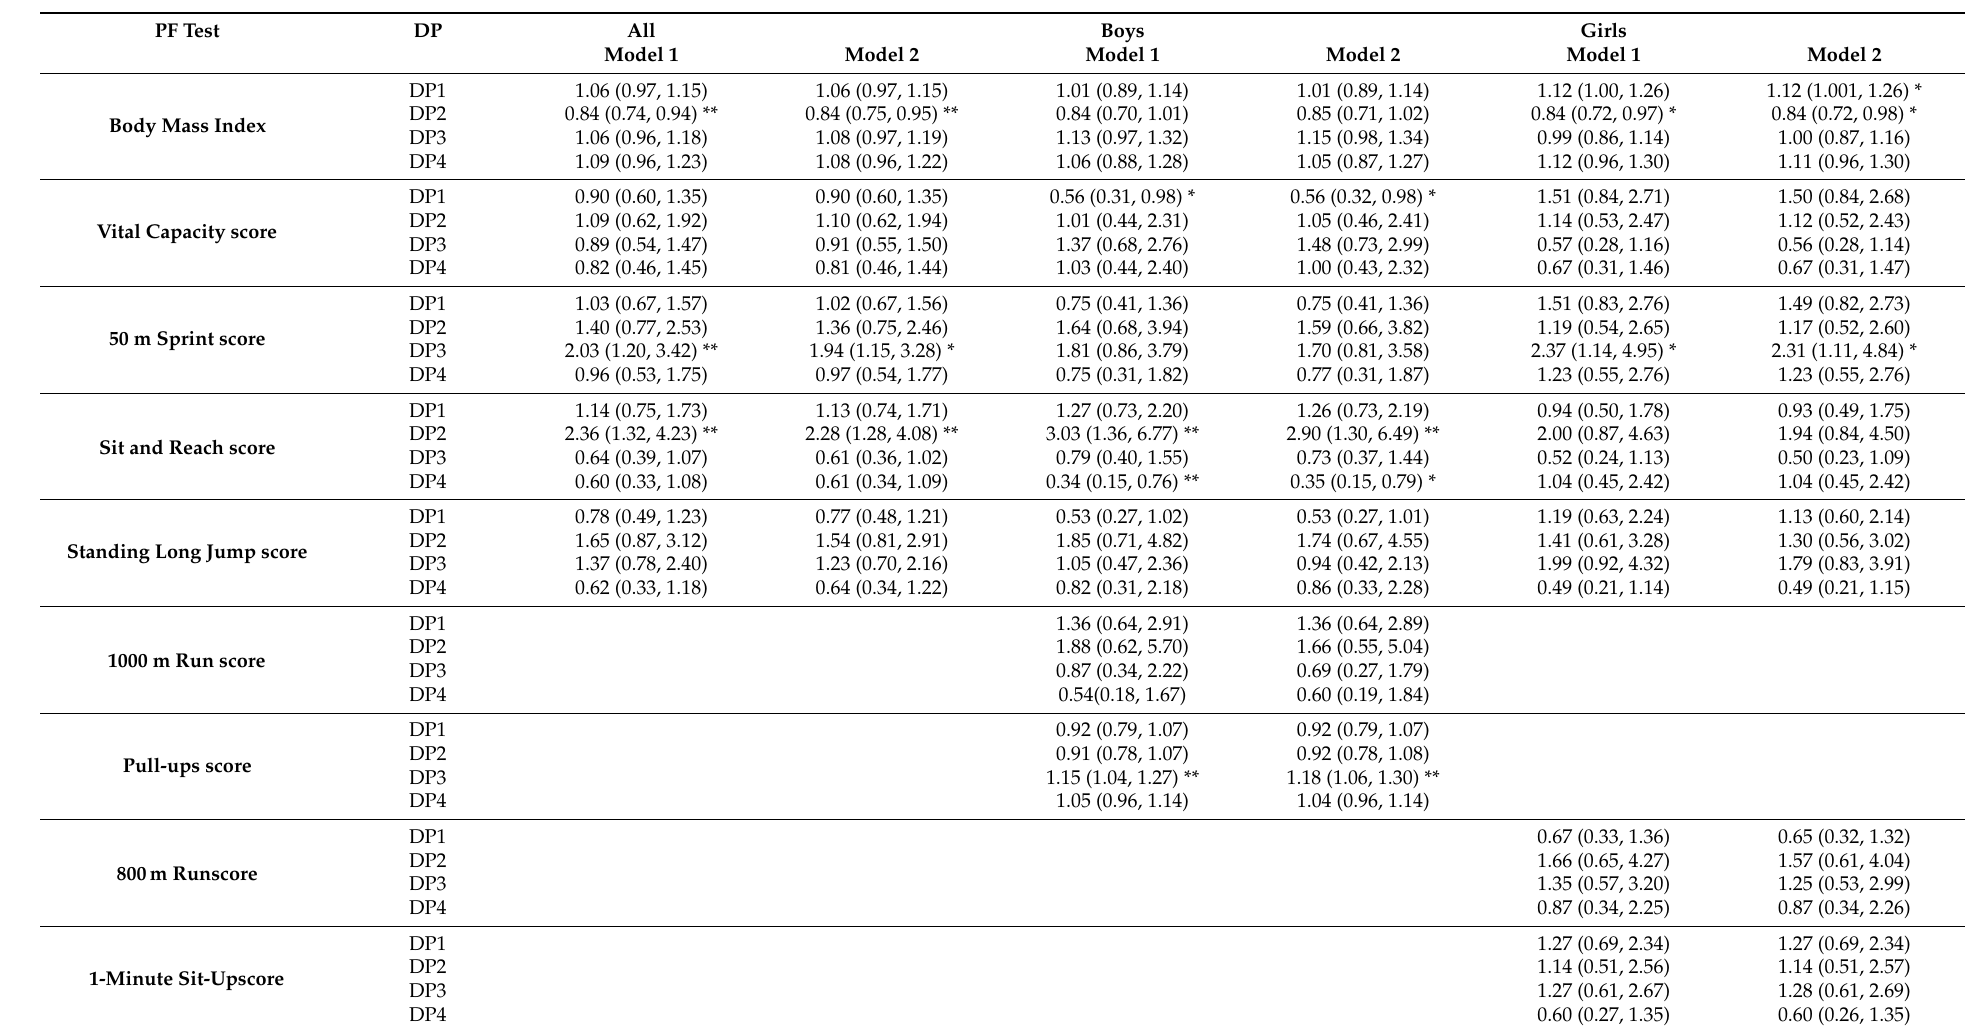
Table 5. Linear regression analysis between dietary patterns and physical